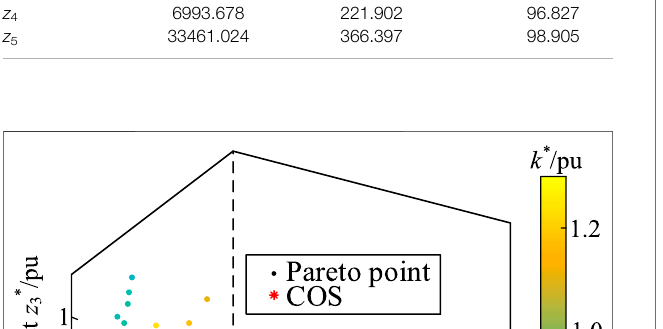
FIGURE 7 | Pareto frontier obtained by the curve-based ε -constraint